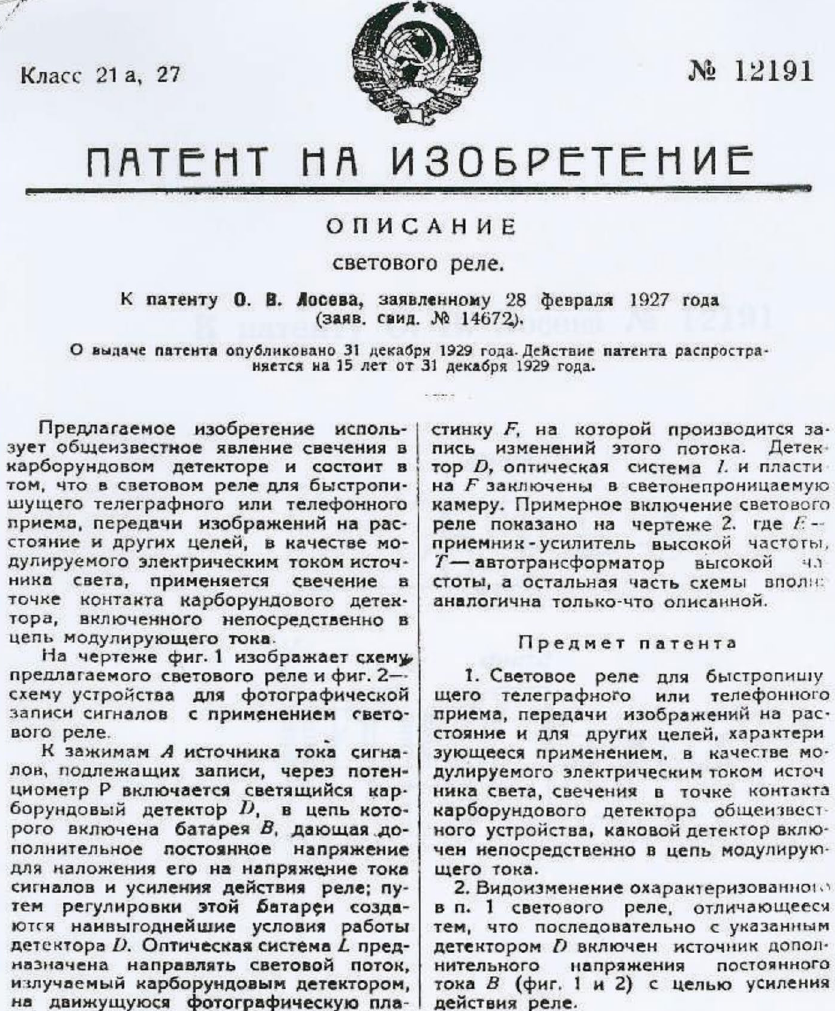
Fig. 1 “One of the historical papers: Losev’s facsimile patent for light emitters” by NIKOLAY ZHELUDEV, Losev pioneered the realization of light emitters potential for telecommunication. Losev awarded a Ph.D. at the Ioffe Institute in 1938 [1, 6, 7]. Reproduced with permission [1].